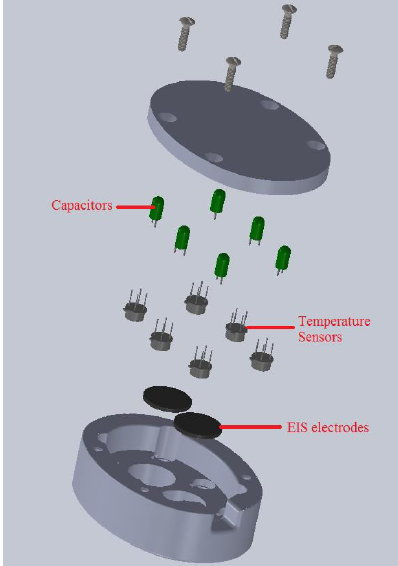
Figure 2: The exploded view of the probe containing electrical impedance electrodes as well as temperature sensors.